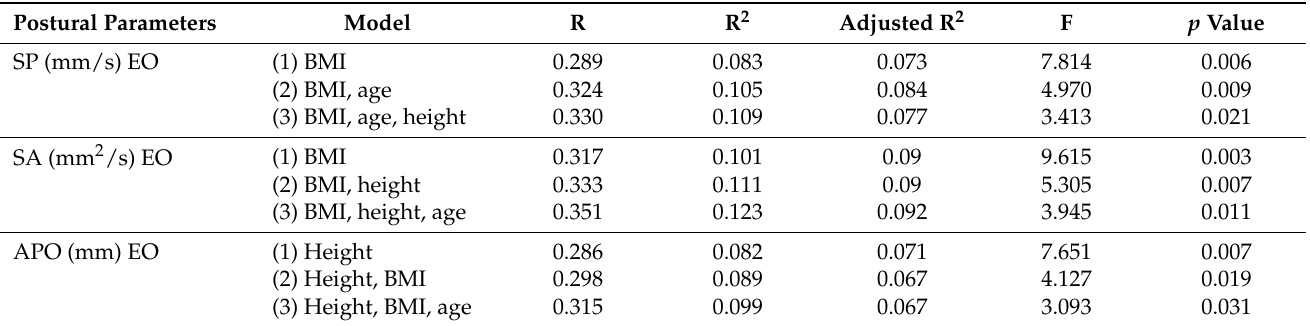
Table 4. Linear multiple regression between pre-surgery anthropometric characteristics and postural control outcomes.